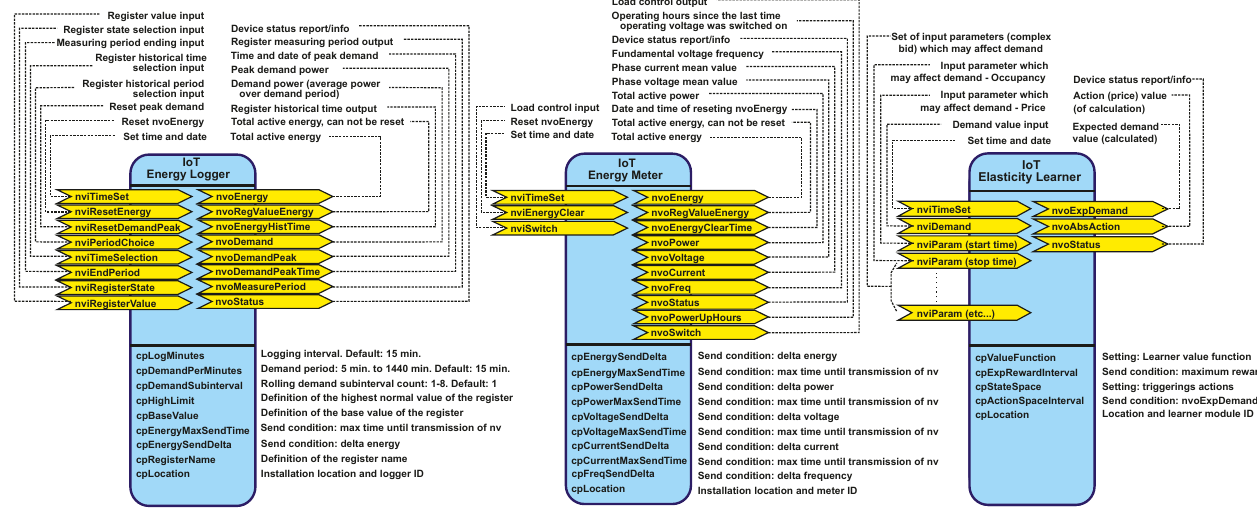
Fig. 1. A developed Agilometer functional